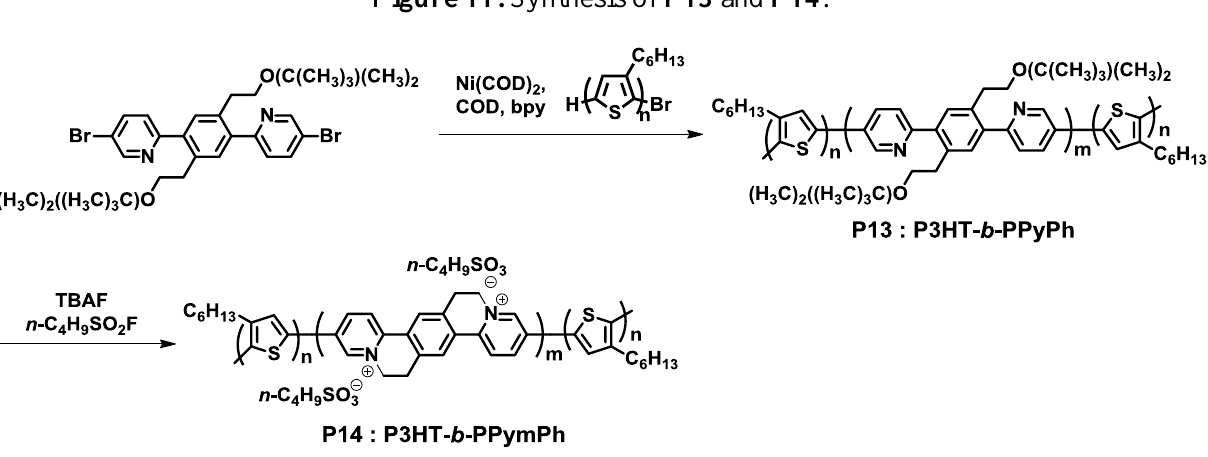
Figure 11. Synthesis of P13 and P14 .